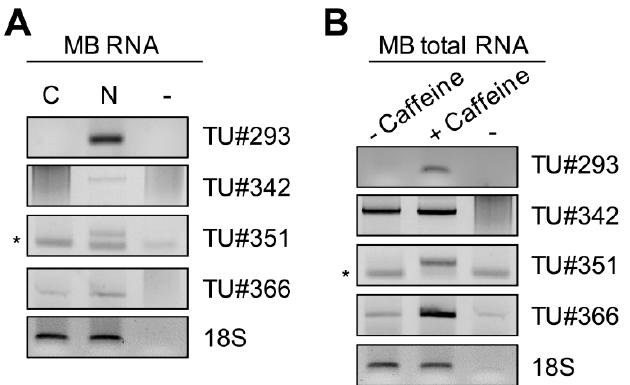
Figure 5. Discovery of new transcripts surrounding the new intergenic snoRNAs. ( A ) Nuclear and cytoplasmic fractionation of myoblasts (MBs) was performed prior to RNA extraction. Newly identified transcriptional units surrounding the intergenic snoRNA candidates (indicated as TU#) were detected by RT-PCR (n = 2). ( B ) MBs were treated with or without a 10nM solution of caffeine for 8 h to inhibit the non-sense mediated decay pathway. Then, total RNA from MBs was extracted, and new TU#s were detected by RT-PCR (n = 2); 18S ribosomal RNA (18S) was used as an invariant control; -: mock PCR; *: primer dimers.